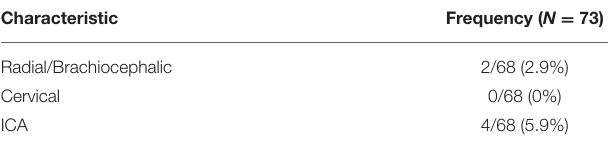
TABLE 1 | Patient and lesion